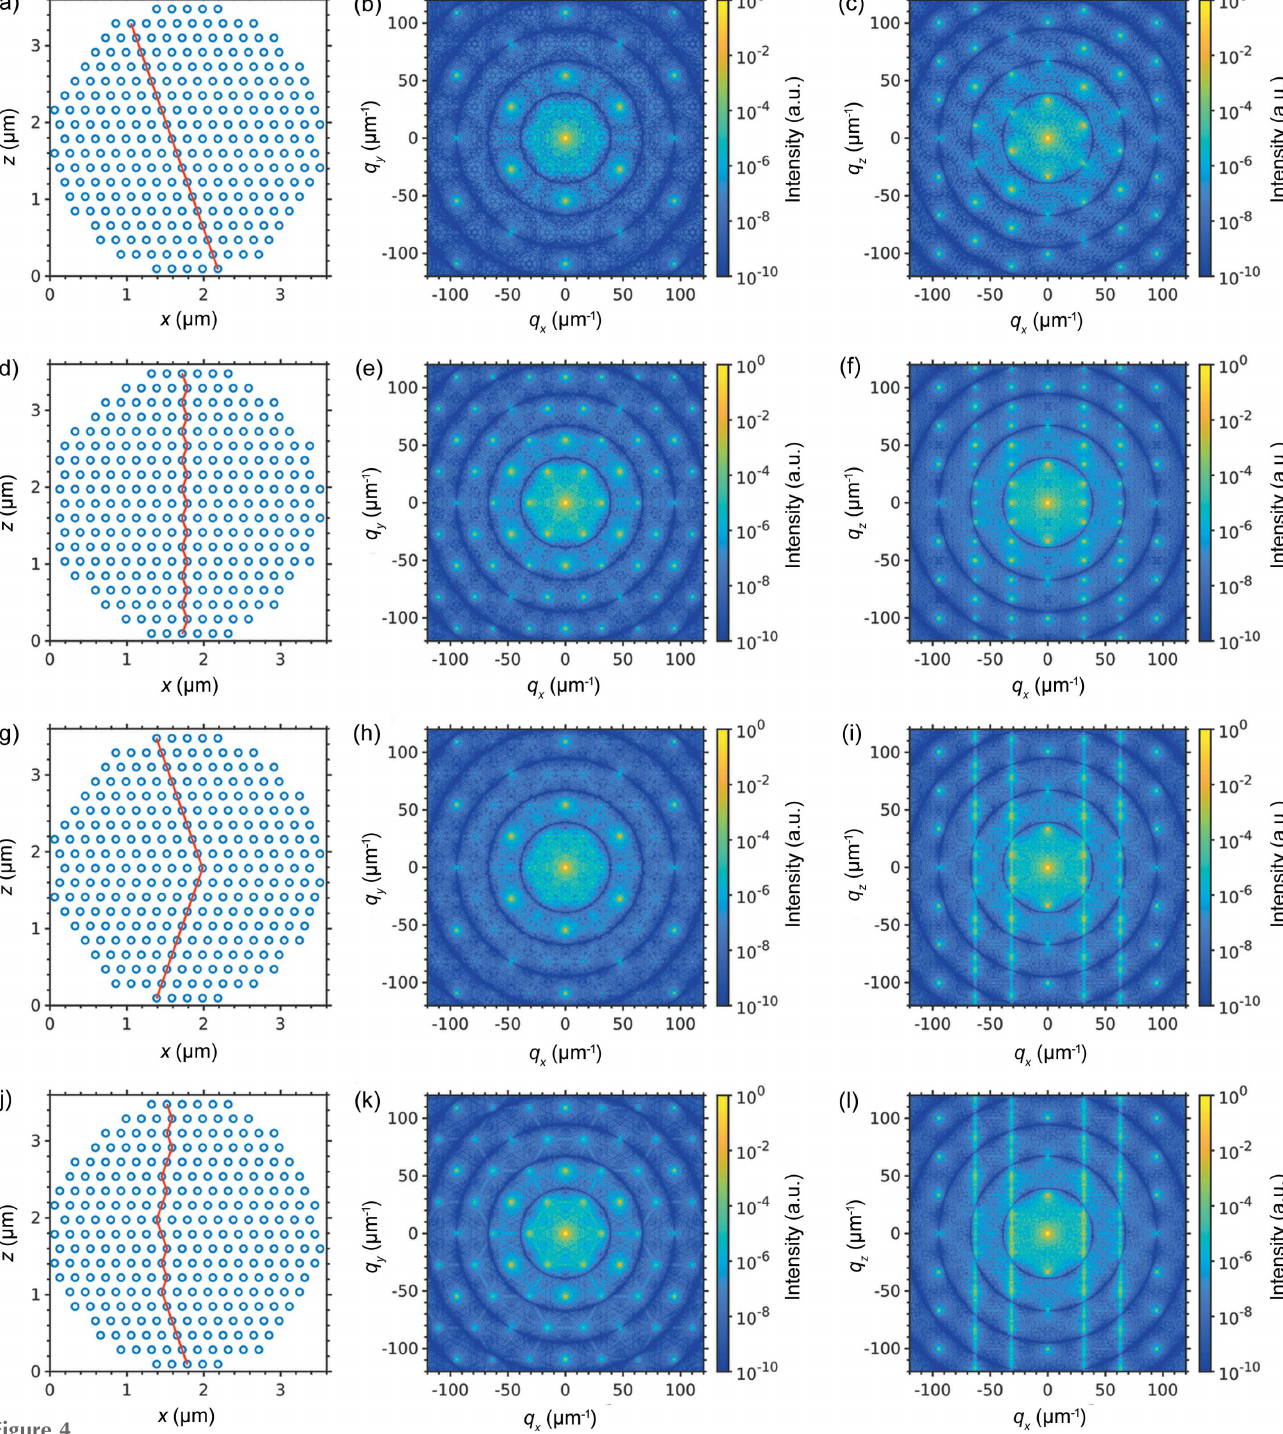
Figure 4 Simulation of 2D diffraction patterns from the structures: ( a )–( c ) f.c.c., ( d )–( f ) h.c.p. ( g )–( i ) twinned f.c.c. domains and ( j )–( l ) r.h.c.p. The first column contains the simulated structures viewed along [1 10] f.c.c. /[100] h.c.p. , the stacking direction [111] f.c.c. /[001] h.c.p. is along the z -axis. The red lines denote the stacking sequence. The second column contains diffraction patterns simulated for an incident beam along the stacking direction [111] f.c.c. /[001] h.c.p. . The third column contains diffraction patterns simulated for an incident beam along the direction [110] f.c.c. /[110] h.c.p.